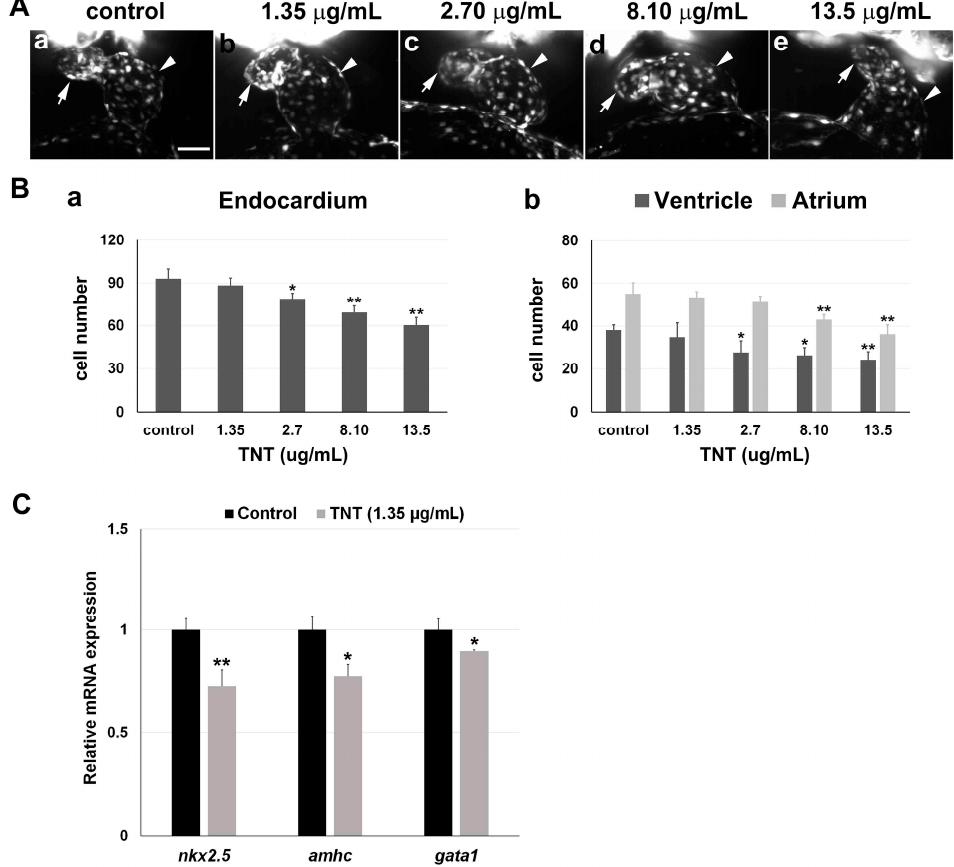
Figure 3. 3D light-sheet imaging/SPIM (Single Plane Illumination Microscopy) of TNT cardiac toxicity. ( A ) TNT in pink water caused abnormal cardiac looping in a dose-dependent manner. ( a – e )